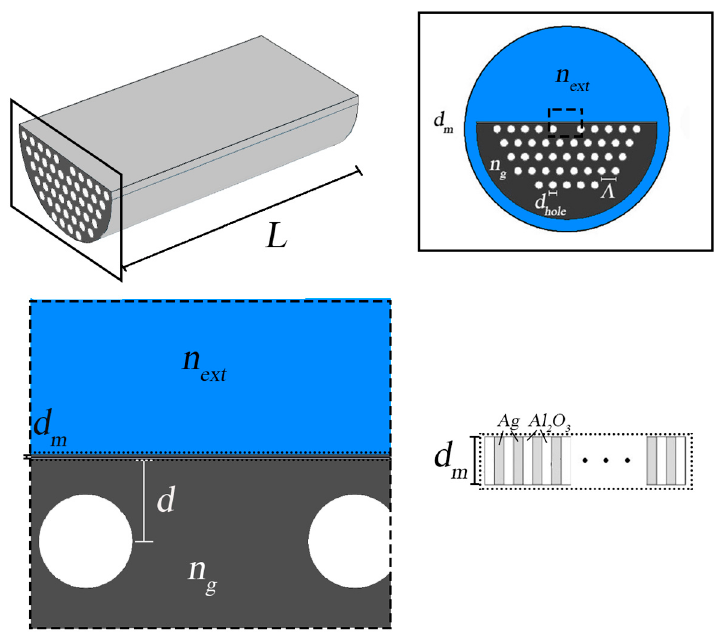
Figure 7. From upper left to lower right: 3D image of the fiber sensor, cross-section of the fiber, structure of the metamaterial surface and a scheme of the thin dielectric-metal layers that constitute the metamaterial.